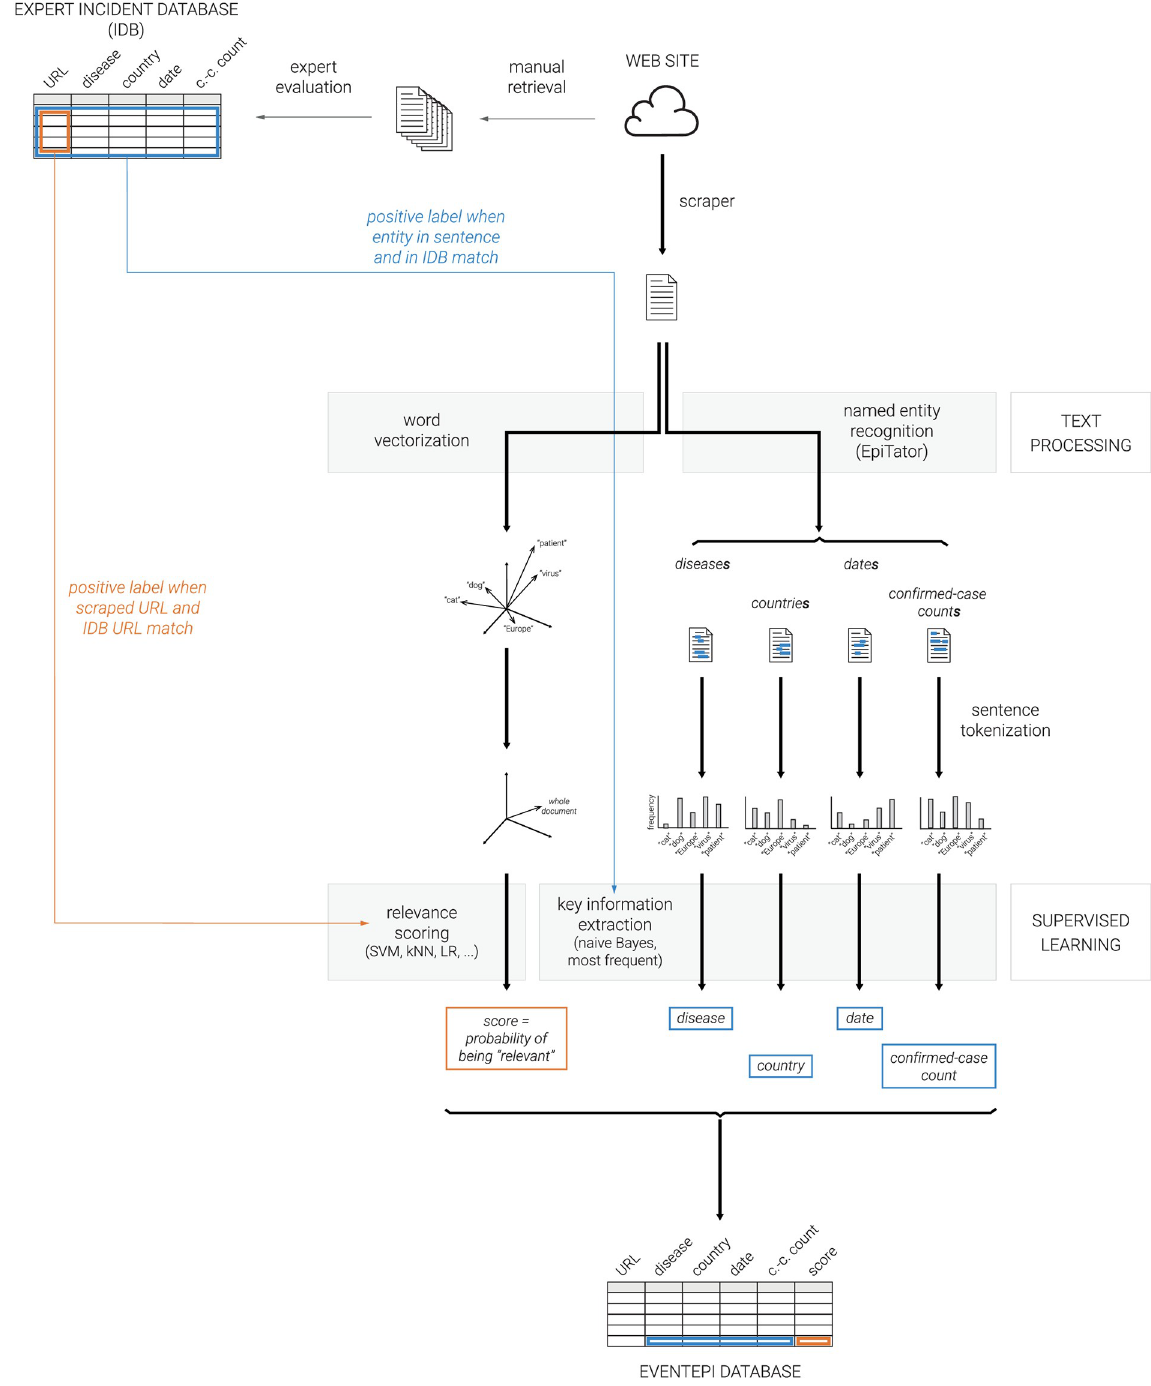
Fig 1. An illustration of the EventEpi architecture. The orange part of the plot describes the relevance scoring of epidemiological texts vectorized with word embeddings (created with word2vec), document embeddings (mean over word embeddings), and bag-of-words, and fed to different classification algorithms (support vector machine (SVM), k-nearest neighbor (kNN) and logistic regression (LR) among others). The part of EventEpi that extracts the key information is colored in blue. Key information extraction is trained on sentences containing named entities using a naive Bayes classifier or the most-frequent approach applied to the output of EpiTator, a epidemiological annotation software. The workflow ends with the results being saved into the EventEpi database that is embedded into EventEpi ’s web application.